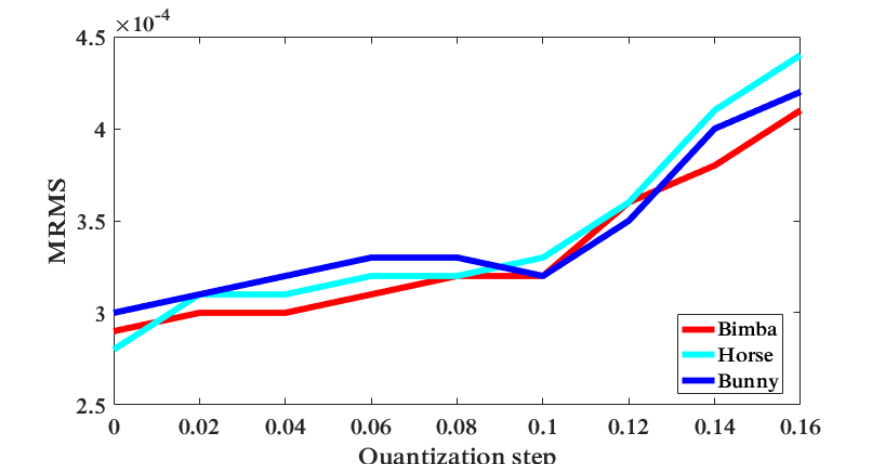
Figure 9. The imperceptibility performance in terms of MRMS using several quantization steps for Bimba, Horse, and Bunny